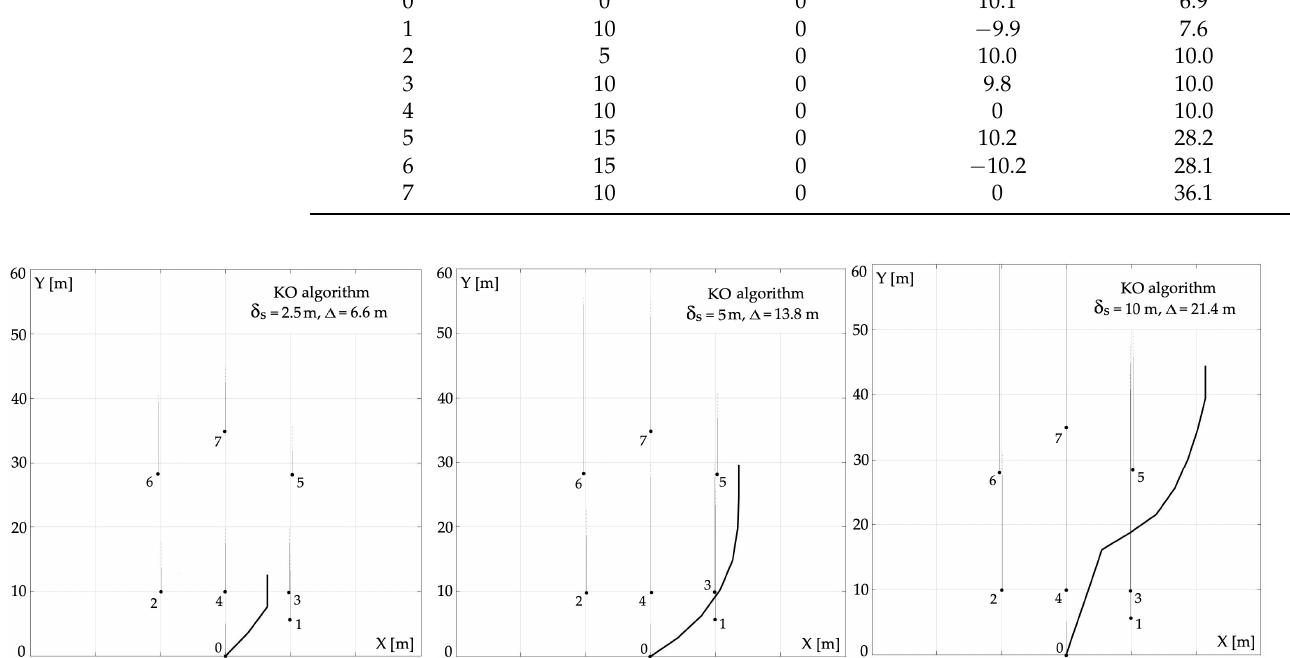
Figure 12. Safe kinematic trajectory of our autonomous vehicle in one-way traffic while passing seven other autonomous vehicles for three safe passing distance values.